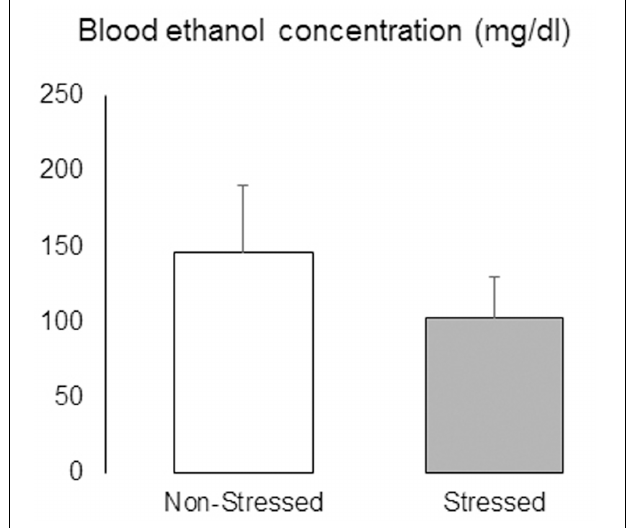
FIGURE 11 | Blood ethanol concentrations (mg/dl) in non-stressed controls and socially defeated mice with a history of continuous access to ethanol. After the last test day, mice were given continuous access to ethanol and water for 48 h before being deeply anesthetized and had blood samples collected by cardiac puncture. Data are mean ± SEM. n = 11 mice per